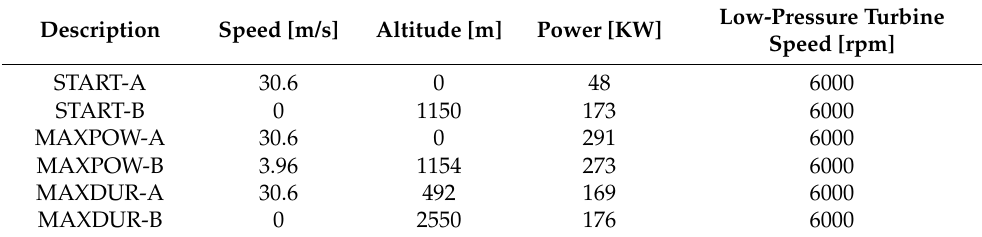
Figure 2. Reference missions. ( a ) Mission A for “Transport”; ( b ) Mission B for “Mountain Rescue”. Table 3. Simulated working points.